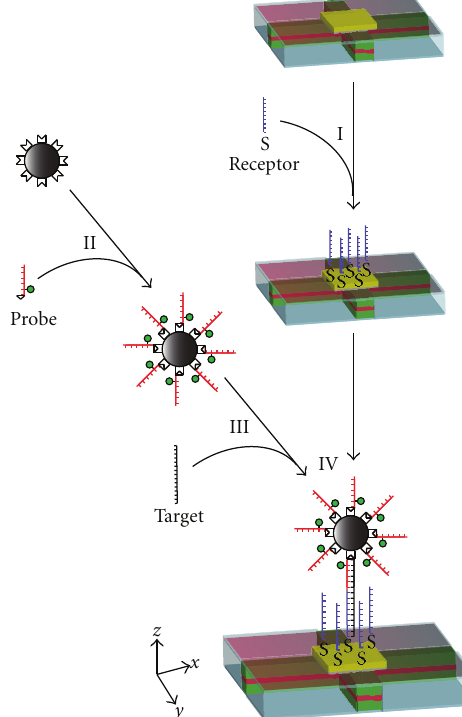
Figure 1: Generalized schematic for the detection of label-free target DNA using Hall magnetometry. The label-free target DNA (black) is detected by immobilization at the Hall device via comple- mentary base pairing with receptor DNA (blue) preassembled on the Hall device surface to additional complementary probe DNA (red) with an internal fluorescent marker preconjugated to the surface of a magnetic nanobead resulting in a detectable Hall signal. Nanobead is not drawn to